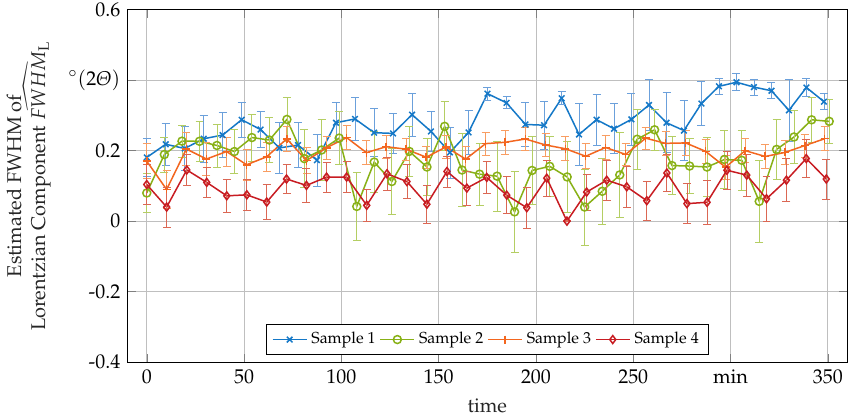
(cid:92) FWHM L of the used Voigt peak shape